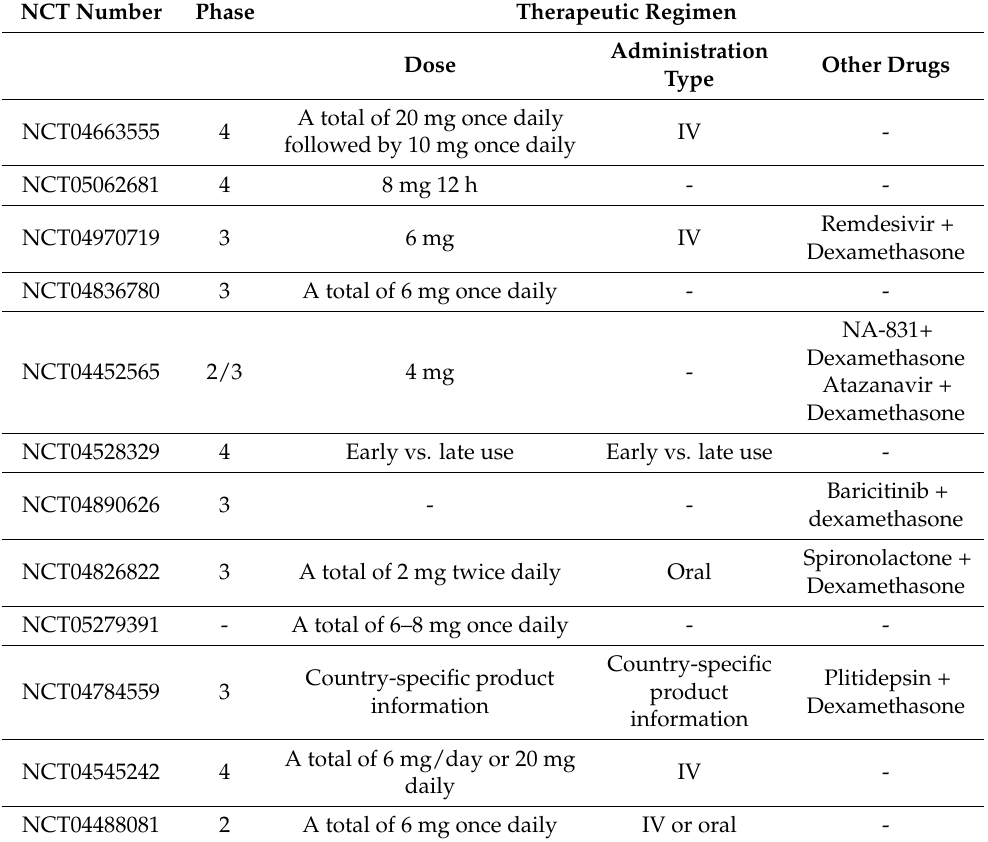
Table 5. Clinical trials using dexamethasone for the treatment of COVID-19. Data was collected from clinicaltrials.gov on 28 November 2022. Inclusion criteria: Recruiting, adult population,